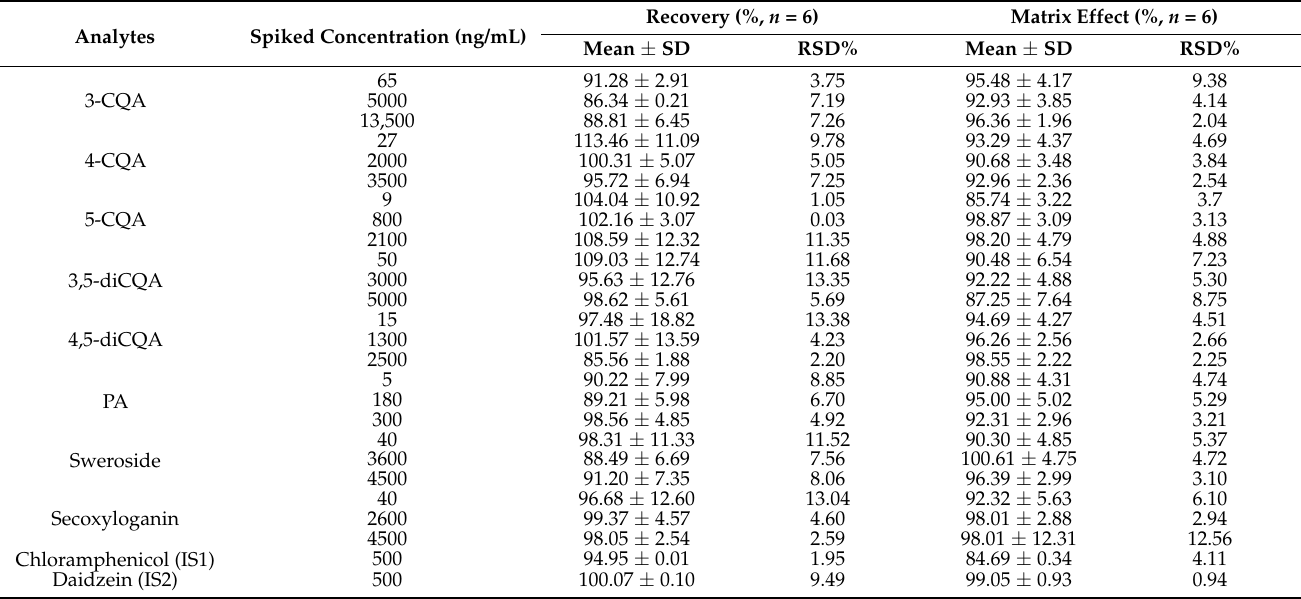
Table 4. Matrix effects and extraction recoveries for the analytes and three internal standards in rat plasma (mean ± SD, n = 6).